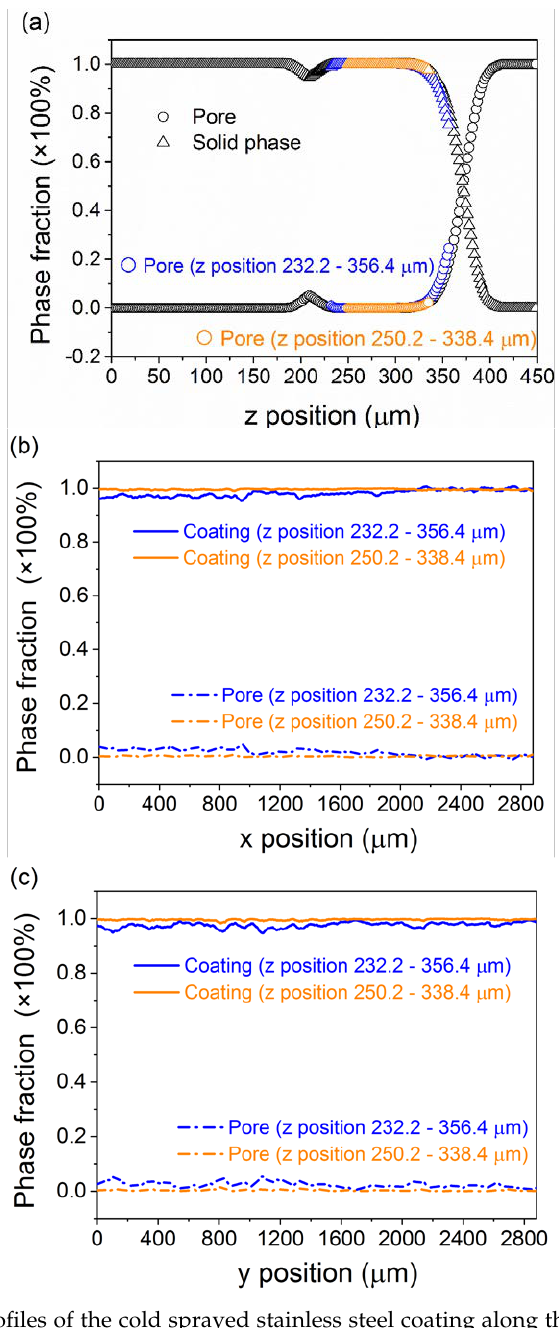
Figure 5. Porosity profiles of the cold sprayed stainless steel coating along the ( a ) z , ( b ) x and ( c ) y directions. Origin of coordinates ( x and z ) is marked in Figure 3.